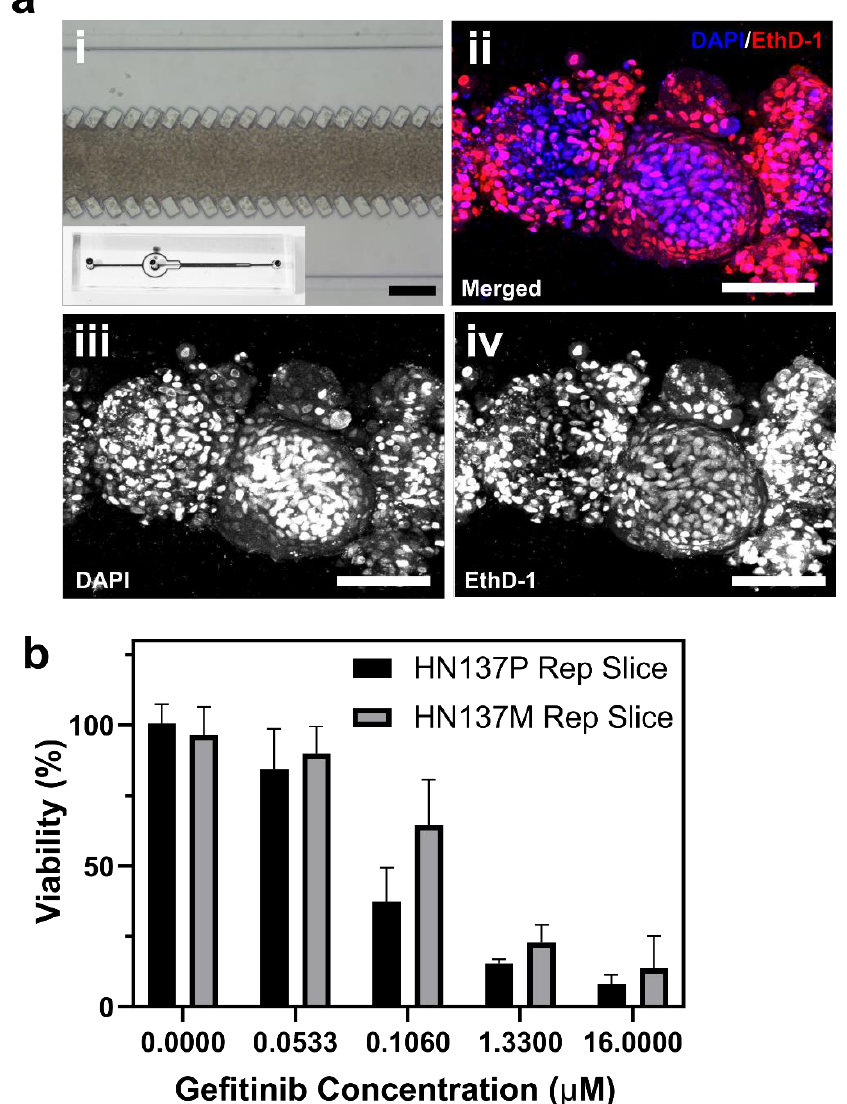
Figure 4. Evaluation of the QuantICV assay in quantifying cell viability in microfluidic 3D cell cultures. ( a ) Images showing 3D cultures of patient-derived (OSCCs) in microfluidic devices. ( i ) Transmission image showing a densely packed 3D tumor aggregate in the central compartment of the microfluidic device (inset). ( ii – iv ) Confocal images of patient-derived parental (HN137P) after double nuclear labeling, ( ii ) merged, ( iii ) DAPI + , ( iv ) EthD-1 + . Cells were exposed to 1.33 µM of Gefitinib cultured within microfluidic perfusion devices. Scale bars = 100 µm. ( b ) Cell viabilities of parental (HN137P) and metastatic (HN137M) OSCCs after Gefitinib treatment using the QuantICV assay. Data are averages of n ≥ 3 devices ± standard deviation (SD).